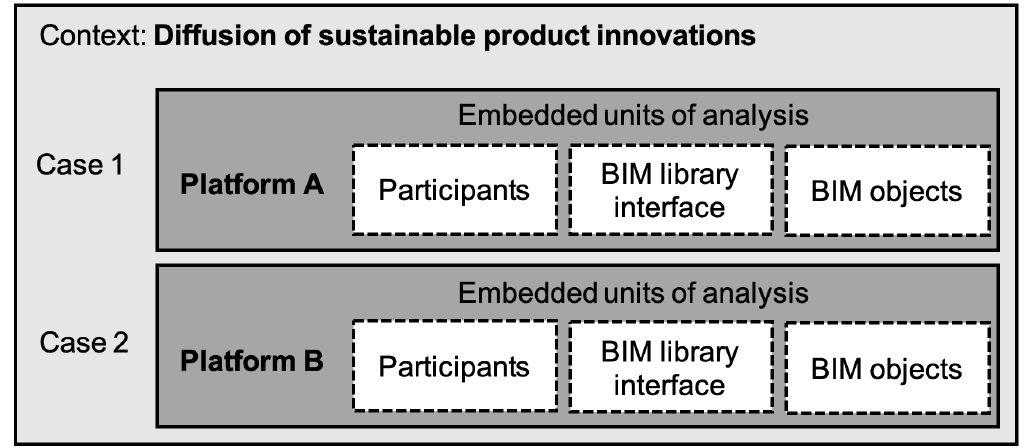
Fig. 2. Multiple-case study